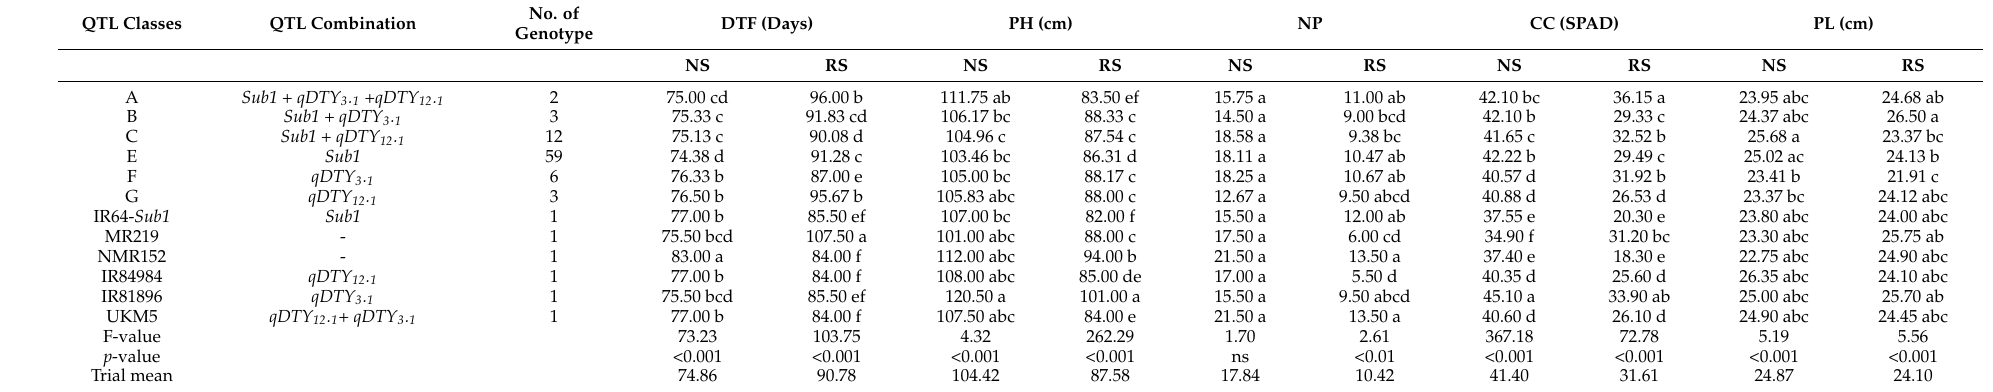
Table 2. Mean of quantitative trait loci (QTL) classes and checks for traits days to 50% flowering (DTF), plant height (PH), number of panicle per plant (NP), chlorophyll content (CC) and panicle length (PL) evaluated in non-stress (NS) and reproductive stage drought stress (RS) trials.